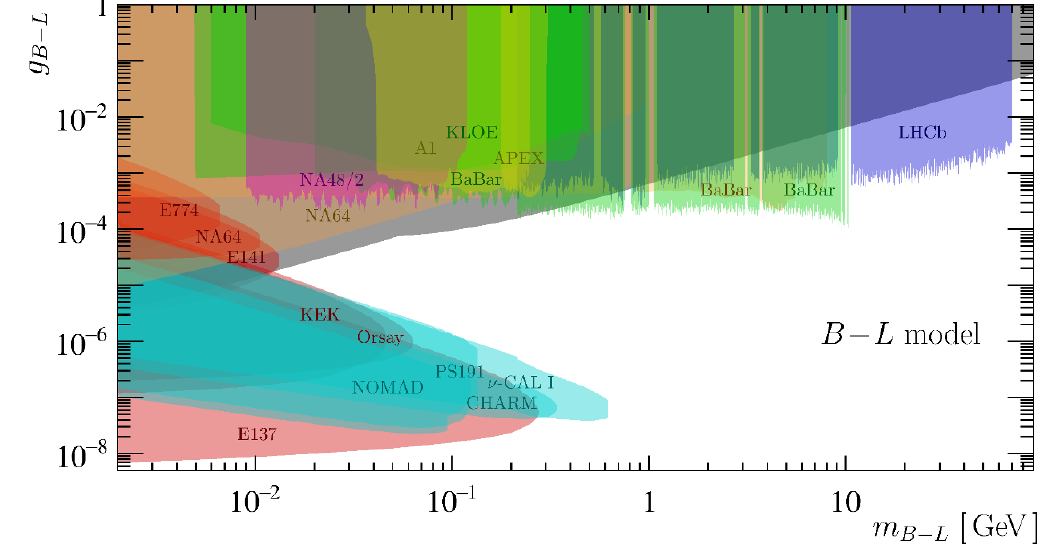
Figure 5 . Constraints derived on B L decays to SM (cid:12)nal states using the same experimental color (cid:0) scheme as in (cid:12)gure 4. The (orange) invisible constraints also apply to B L due to its coupling to (cid:0) neutrinos. The grey constraints are from Borexino [96, 97], Texono [92, 98], CHARM-II [92, 99], and from SPEAR, DORIS, and PETRA [100, 101].